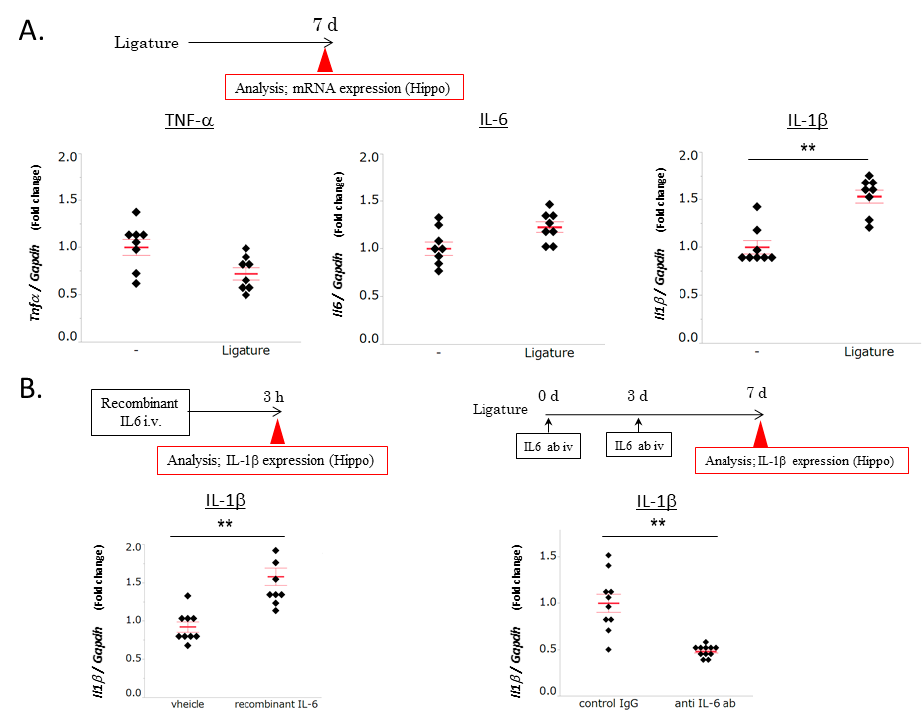
Figure 2. Effects of ligature-induced periodontal disease (PD) on the proinflammatory cytokine expression levels in the hippocampus. ( A ) TNF- α , IL-6, and IL-1 β mRNA expression levels in the hippocampus. Ligatures were placed for 1 week (mean ± SE, n = 8/group). ** p < 0.01 significantly different from the control, the Student’s t- test. ( B ) Recombinant IL-6 or vehicle was administered intravenously for 3 h, and the hippocampus was then collected. An anti-IL-6 antibody or control IgG was intravenously injected into ligature-induced PD mice. Antibodies were administered at the beginning and 3 days after ligation (mean ± SE, n = 9–11/group). ** p < 0.01 significantly different from the control, the Student’s t- test.